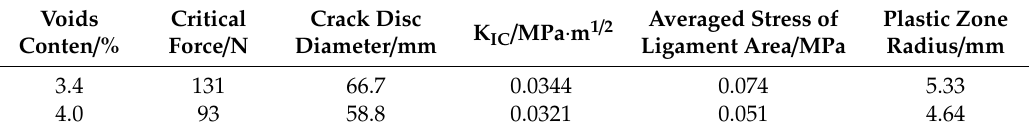
Table 7. Mechanical parameters of the model